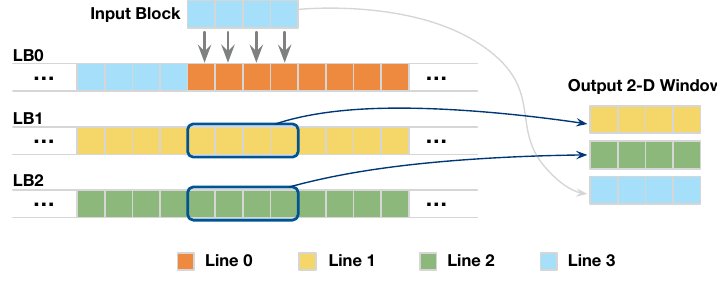
Figure 6. Example of buffer load and store with the line-rolling